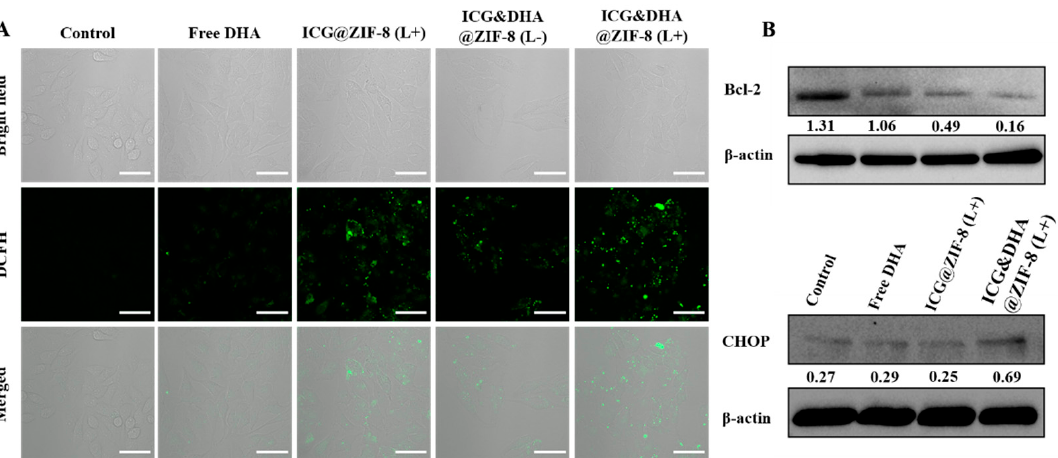
Figure 4. ( A ) Representative confocal microscopic images of intracellular ROS production after incubation with free DHA, ICG@ZIF-8, and ICG&DHA@ZIF-8 with or without laser irradiation (“ICG@ZIF-8 (L+)” means ICG@ZIF-8 with laser irradiation, “ICG&DHA@ZIF-8 (L − )” means ICG&DHA@ZIF-8 without laser irradiation, “ICG&DHA@ZIF-8 (L+)” means ICG&DHA@ZIF-8 with laser irradiation). Scale bars: 50 nm. ( B ) Western blot analysis of CHOP and Bcl-2 protein expression in HepG2 cells treated with free DHA, ICG@ZIF-8, and ICG&DHA@ZIF-8 with laser irradiation.